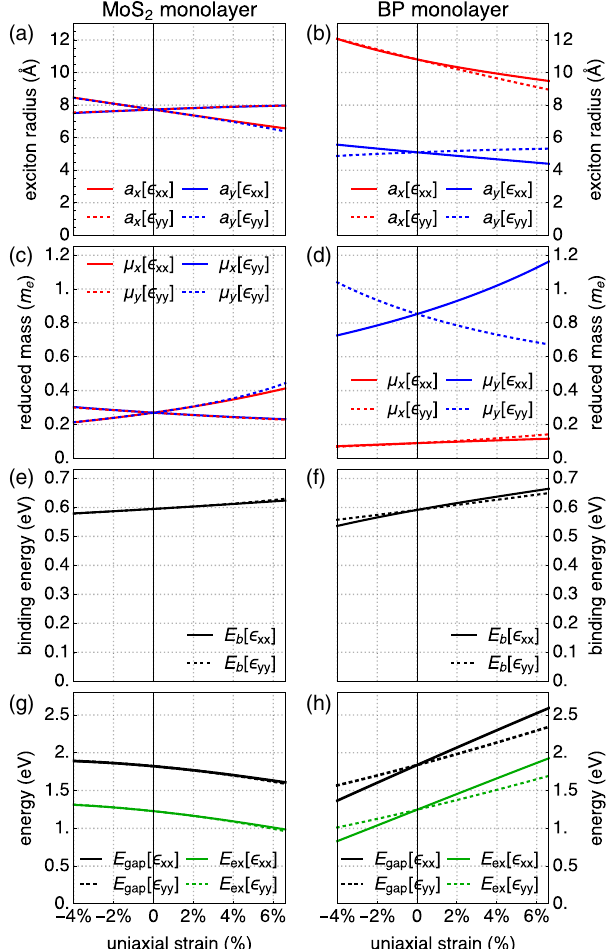
FIG. 3. Exciton properties as a function of uniaxial strain in the x (armchair) and y (zigzag) directions for MoS 2 (left column) and BP (right column) monolayers. Both materials remain in a direct- gap regime within the chosen range of strains. (a,b) Exciton radii a . (c,d) Reduced exciton masses μ . (e,f) Binding energy E . x;y x;y b (g,h) Band gap E and exciton energy E gap ex